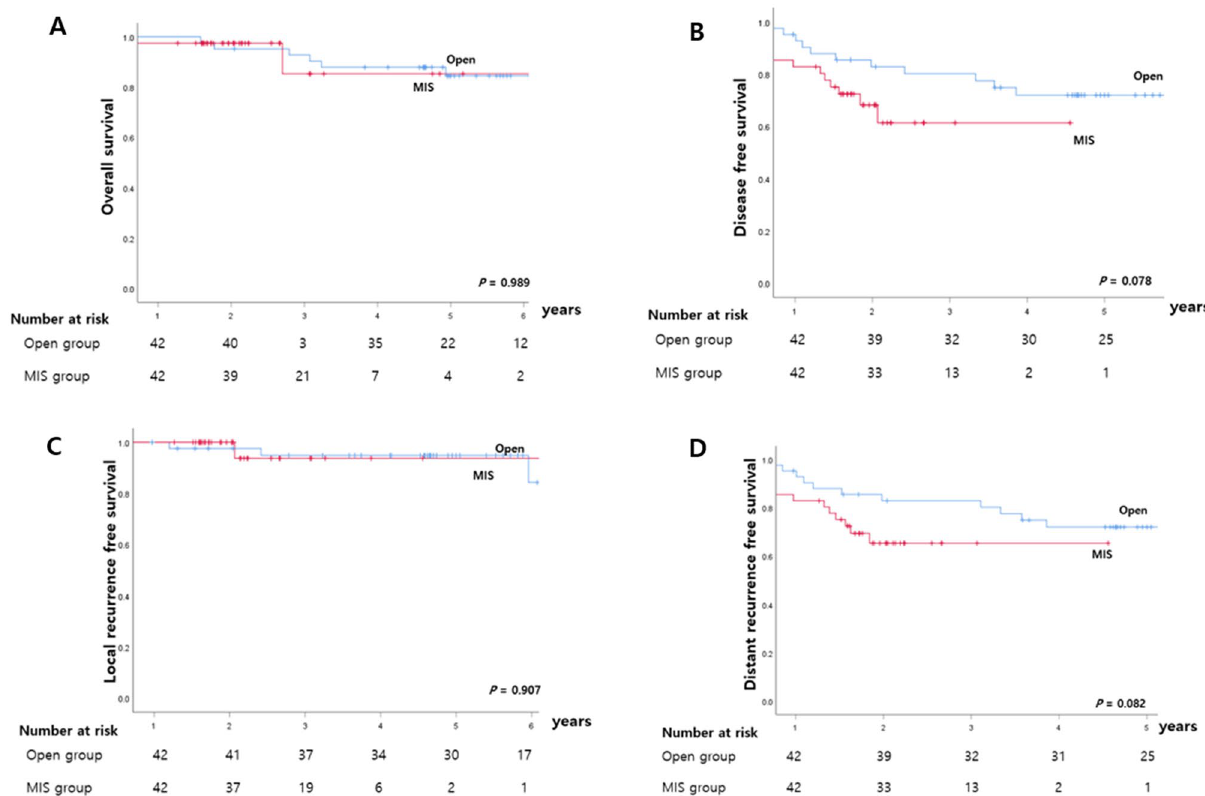
Figure 3. Five-year survival rates of matched patients who underwent nCRT: ( A ) overall survival, ( B ) disease- free survival, ( C ) local recurrence-free survival, ( D ) distant recurrence-free